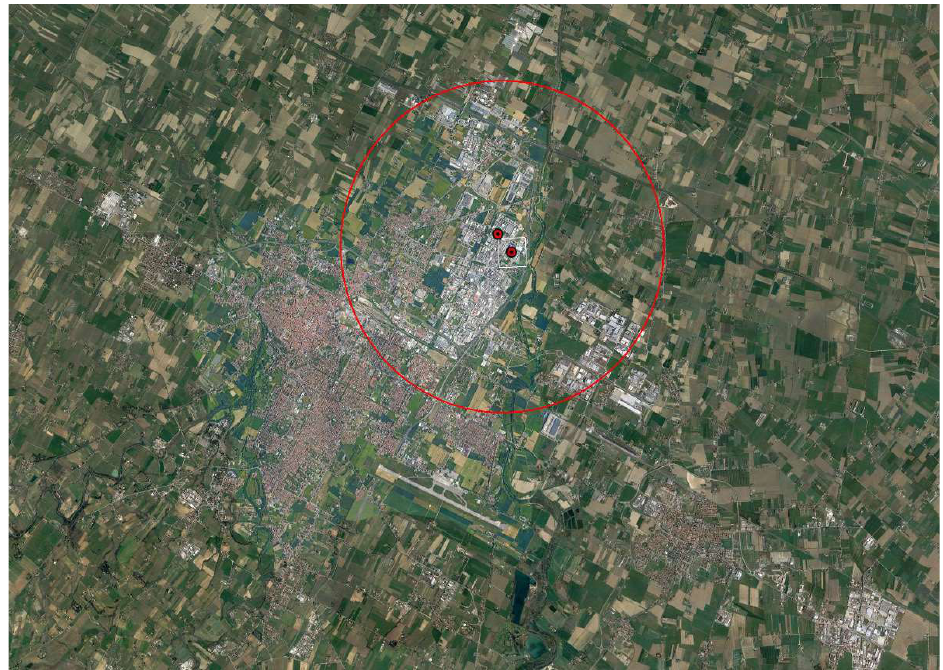
Figure 1. Study area around incinerators (filled circles), in the city of Forlì (Emilia-Romagna, Northern Italy). Exposed subjects considered were 62 children living within a 3 km radius circle around the two incinerators, with the circle centered in the middle of the distance between the two plants. A total of 158 enrolled children were residents in the remaining city areas (reference area).